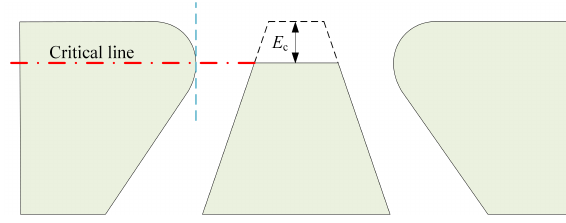
Figure 24. Failure criterion of